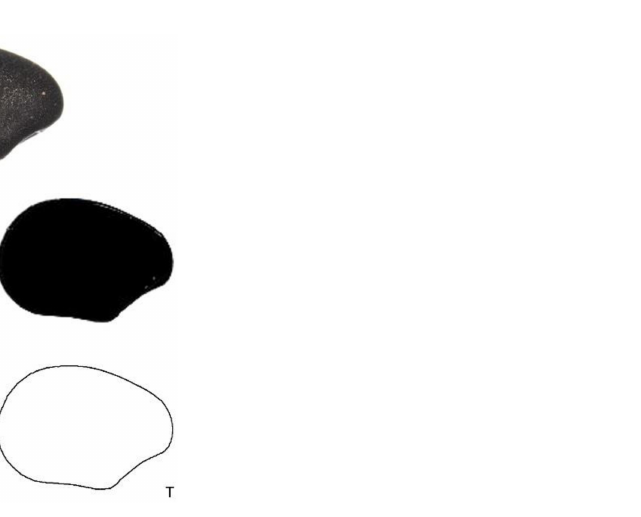
Figure 12. Graphic representation of the method used to calculate the J index. Top: image of a seed of Ferocactus herrerae . Middle: the same image in black with the model superimposed; left: the model in white to obtain the shared area ( S ); right: the model in black to obtain total area ( T ). Below: Interpretation of the images by ImageJ. The values for the estimated areas are 294.241 pixel for the shared ( S ) and 320.870 pixel for the total area ( T ), respectively. The J index of this example equals to